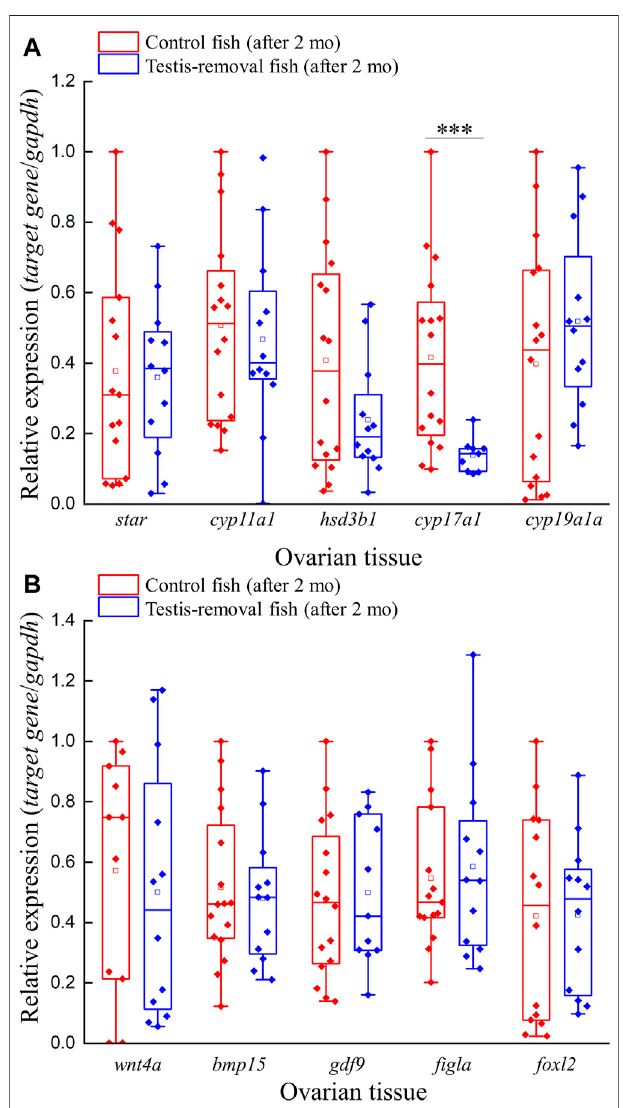
FIGURE 4 | Expression pro fi les of ovarian steroidogenesis-related factors and female-related genes after testis-removal induced femaleness. To clarify the effect of sex steroids and female-related genes in secondary sex determination, we collected the ovarian tissue 2 months after surgery. The relative expression pro fi les of (A) ovarian steroidogenesis-related genes ( star , cyp11a1 , hsd3b1 , cyp17a1 , and cyp19a1a ) and (B) potential female- related genes ( wnt4a , bmp15 , gdf9 , fi gla , and foxl2 ) were detected using qPCR. Relative expression was normalized with gapdh , and the highest sample value of each gene in the control fi sh was de fi ned as 1. Asterisks indicate signi fi cant differences by Student ’ s t -test (***, p < 0.001).